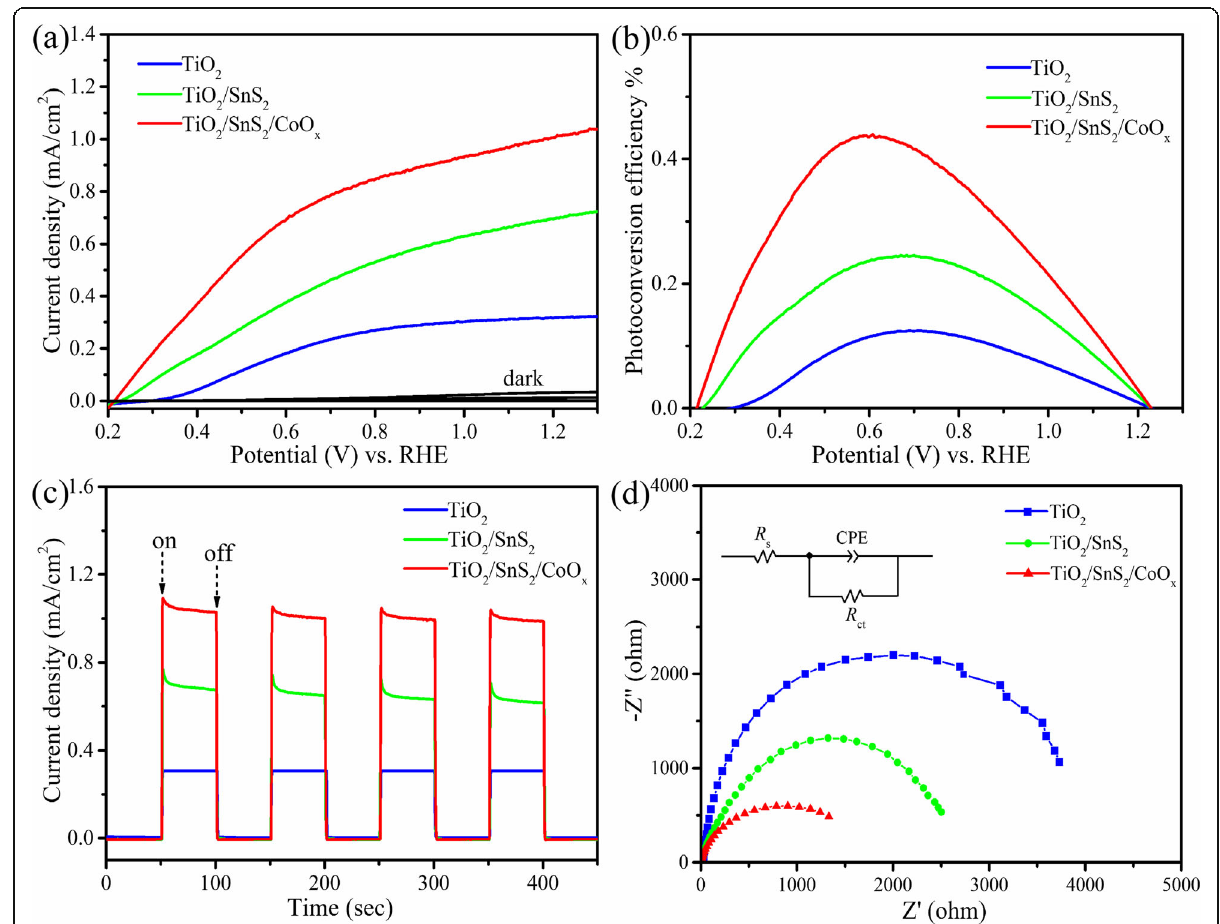
Fig. 4 PEC measurements for pristine TiO 2 , TiO 2 /SnS 2 , and TiO 2 /SnS 2 /CoO x photoelectrodes in 0.5 M Na 2 SO 4 electrolyte. a Photocurrent density- applied potential characteristics. b Calculated photoconversion efficiencies. c Photocurrent density-time plots measured at 1.23 V vs. RHE under chopped light irradiation. d EIS spectra measured under